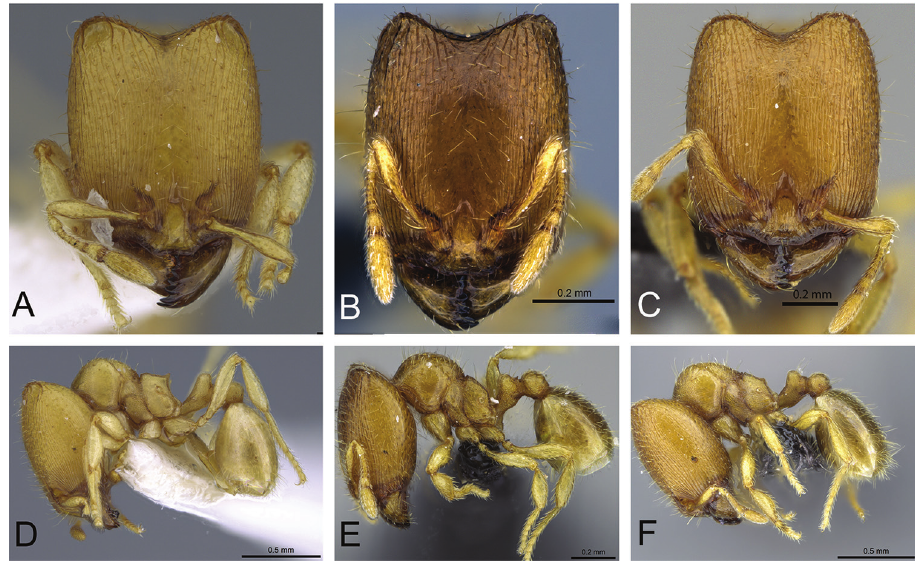
Figure 18. Head in full face-view of A, D Carebara jajoby (CASENT0192567) B, E Carebara vazimba (CASENT0055650) C, F Carebara kabosy (CASENT0162282). 22